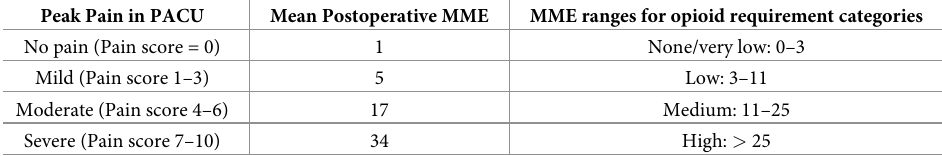
Table 2. Mean postoperative MME requirements for different peak pain levels in